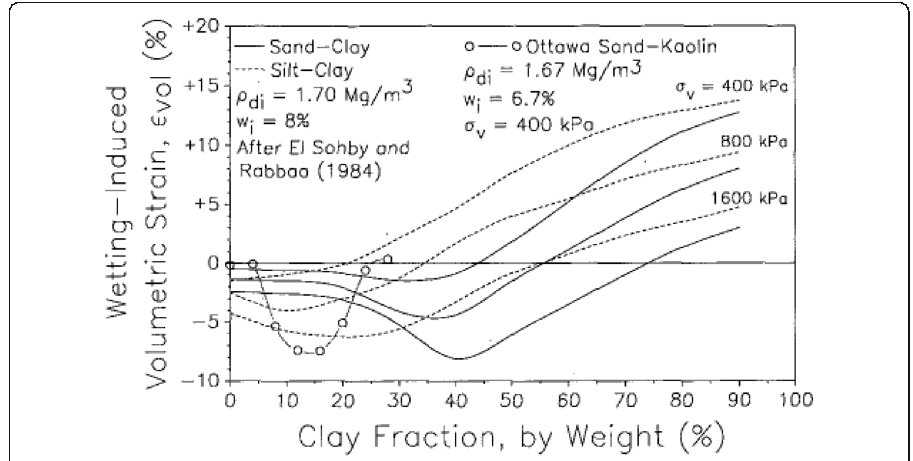
Fig. 8 Effect of clay content on collapse potential (adopted from Lawton